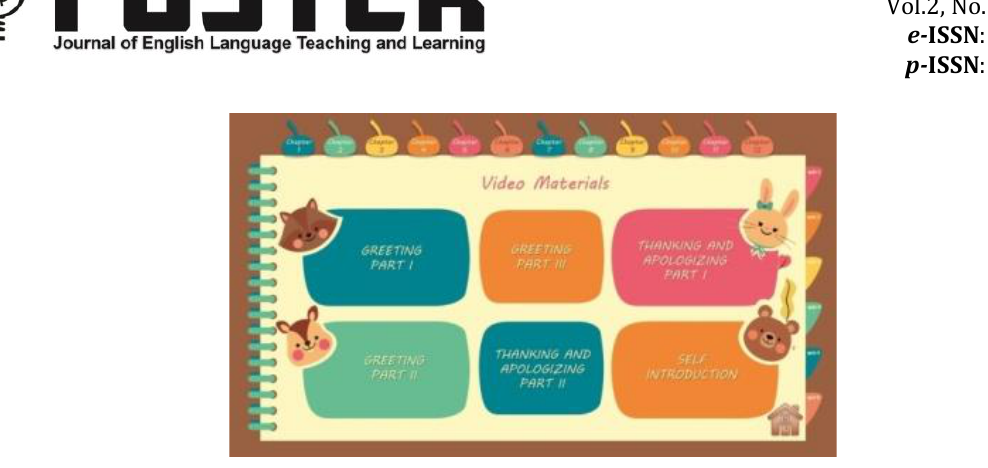
Figure 8. LEEF Video Materials Page